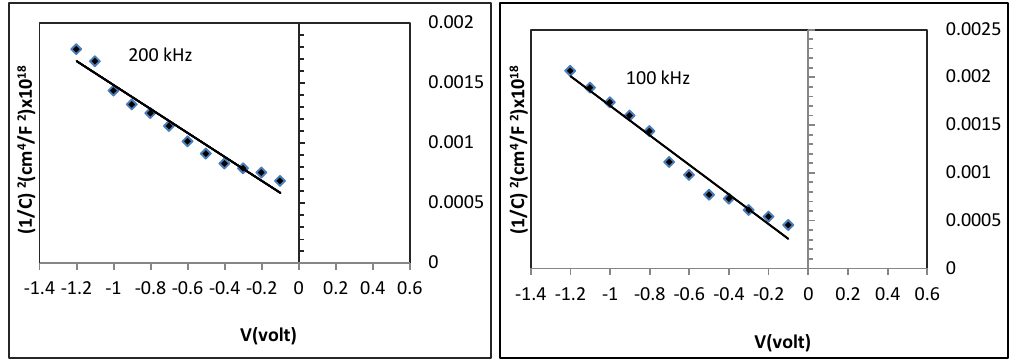
Fig.7: Variation of (1/C) 2 with voltage for ZnO /GaAs at frequencies100 kHz and 200 kHz. Table 6: C-V parameters for ZnO /GaAs heterojunction at f=100 kHz and 200 kHz. W (µm) nx10 14 Frequency C x10 -9 V o bi (kHz) (F/cm 2 ) (cm -3 ) (volt) 100 48 0.10 2.5 0.1 200 39 0.12 2.1 0.15